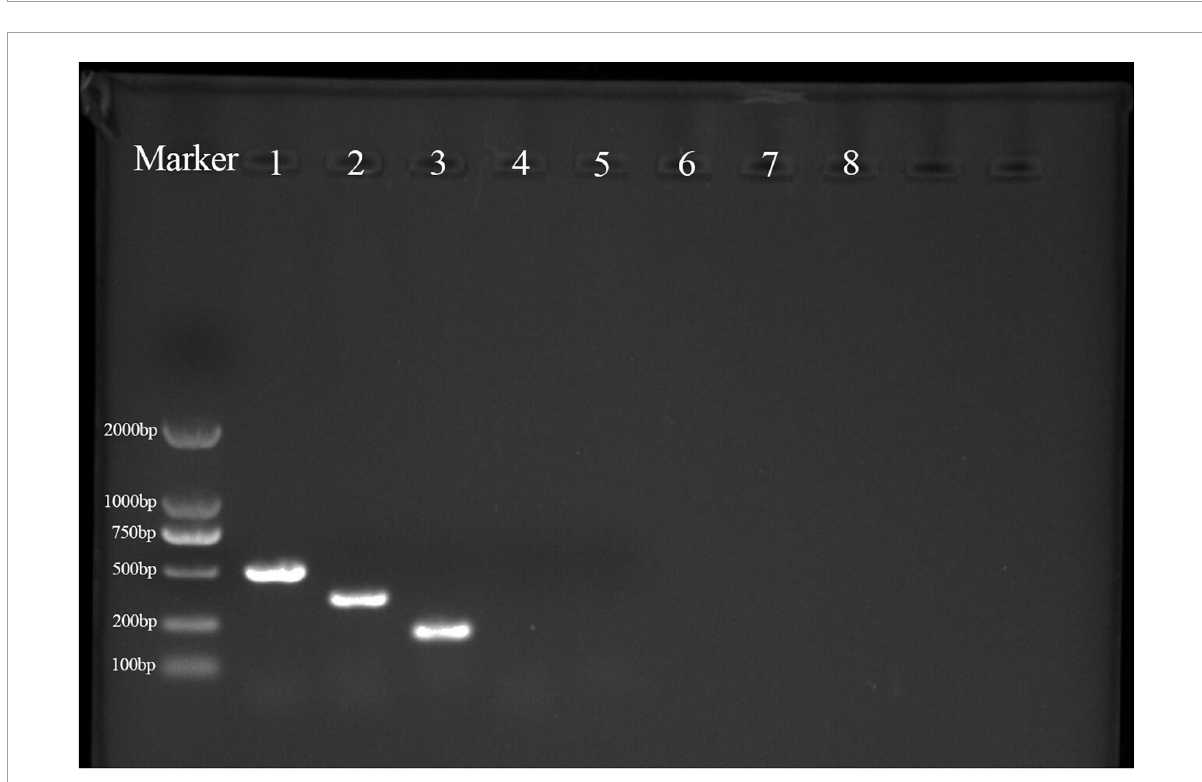
FIGURE9 PCR products were obtained from the amplification of lipopeptide biosynthetic genes in strain YYC 155. M is a size marker; 1–8 are PCR products for genes encoding bacA , ppsD , srfAA , fenD , baC , baE , bmyB, and ituB , respectively. Only primers for the first three genes produced a PCR